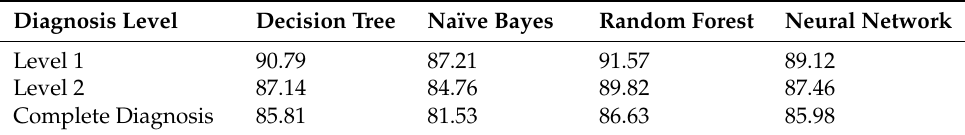
Table 7. Accuracy (%) for classification output at different levels of diagnosis.